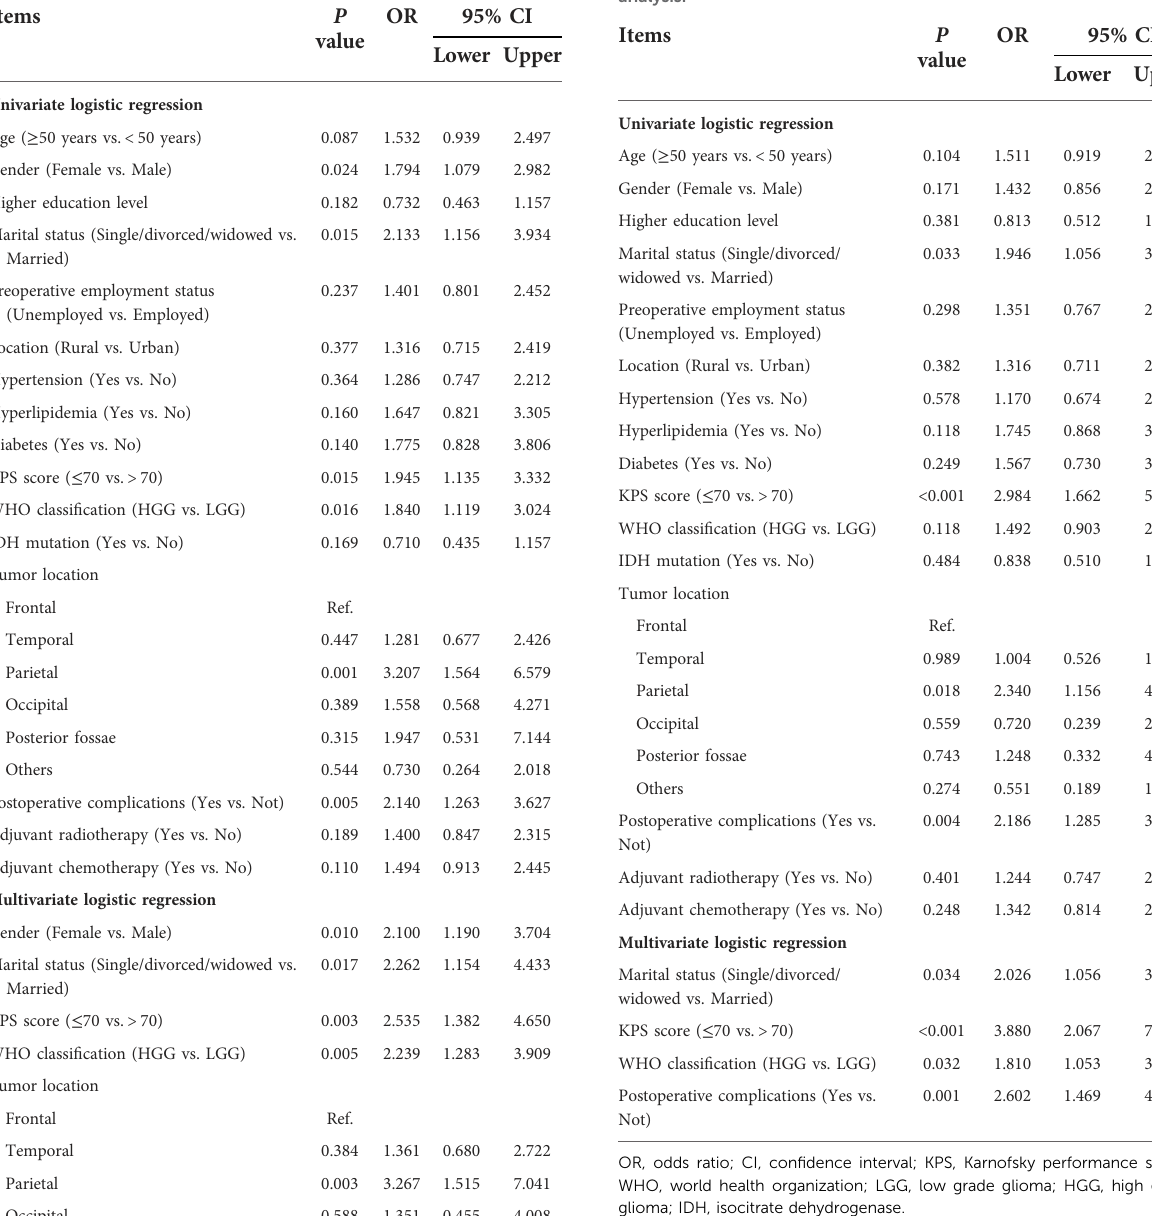
TABLE 2 Risk factors of anxiety by logistic regression model analysis. TABLE 3 Risk factors of depression by logistic regression model